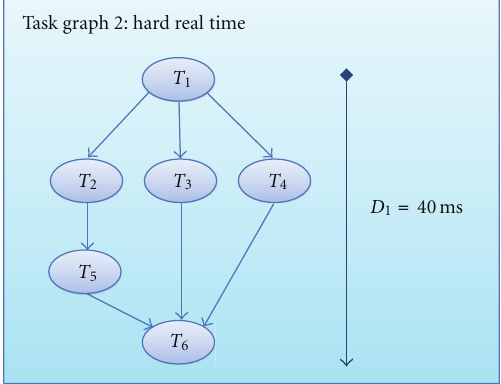
Figure 12: Task graph TG2 of an image-processing application, which detects template-based and point-like objects within an